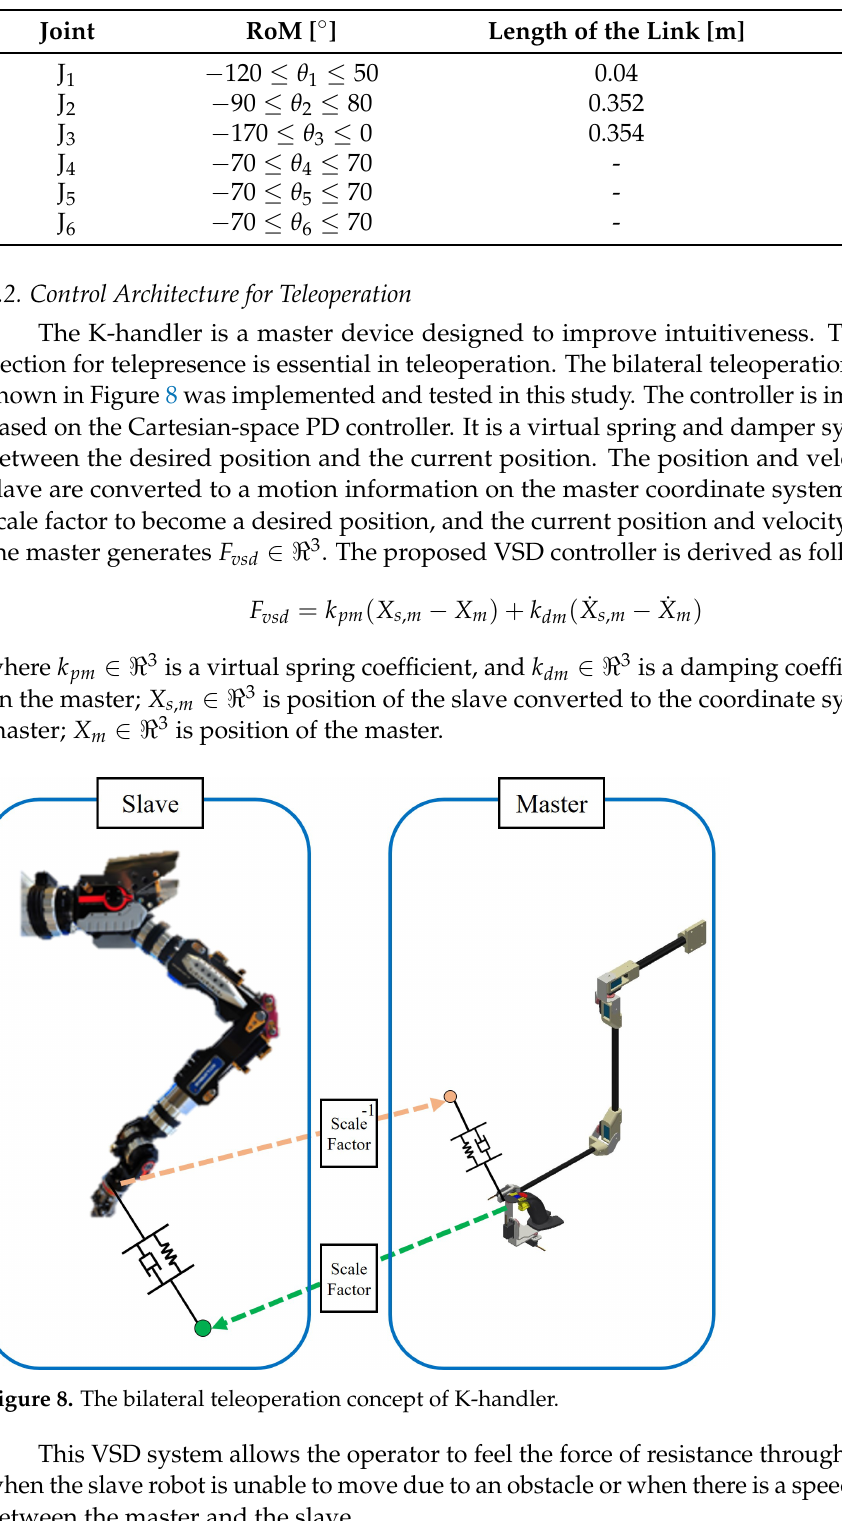
Table 2. Specification of K-handler.